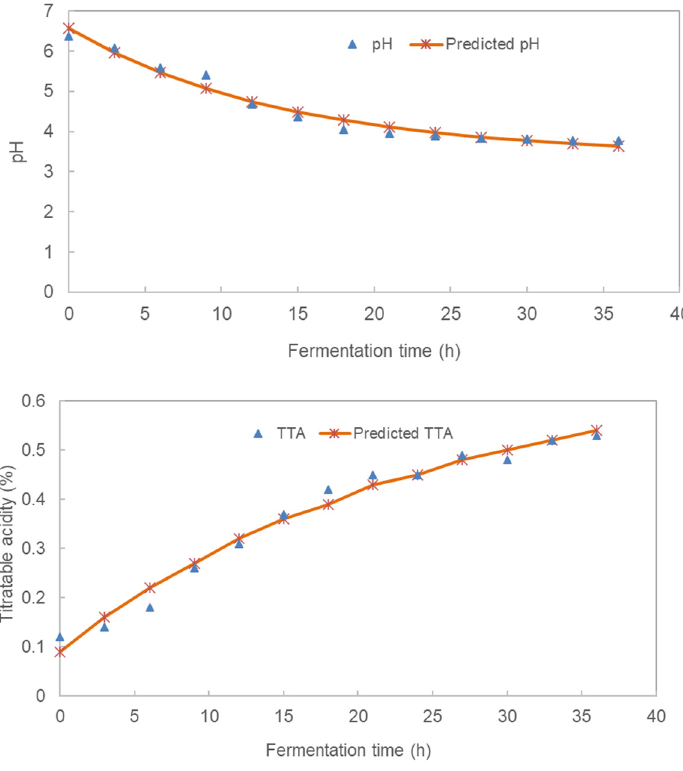
Figure 2. Kinetics of pH and titratable acidity of pearl millet slurry during fermentation. Table 2. Exponential model parameters for the kinetics of pH and TTA of millet slurry during fermentation